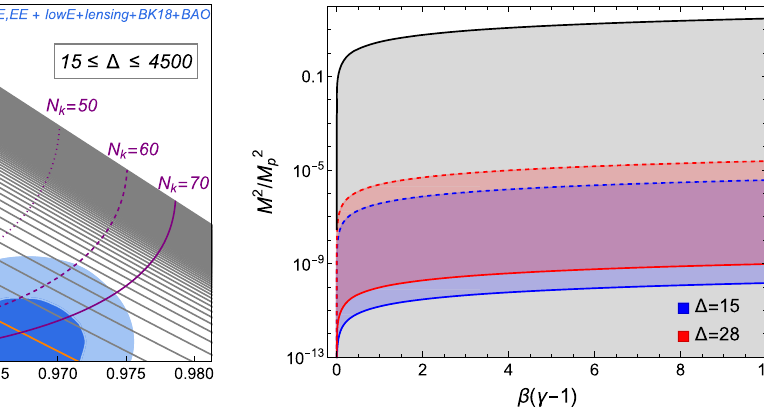
Fig. 2 Left: the n S − r plot for natural inflation with potential given in Eq. (22). The shaded regions present the 1 σ (dark blue) and 2 σ (light blue) contours of the latest Planck+BICEP/Keck 2018 data [28]. The diagonal gray lines indicate the different values of Δ within the inter- val 15 ≤ Δ ≤ 4500, increasing from bottom left to top right with a step of 10. For the orange line, Δ = 20. The purple lines repre- sent the number N k of e -folds during inflation; N k = 50 (dotted), 60 (dashed), and 70 (solid). Right: the parameter space of β(γ − 1 ) vs.